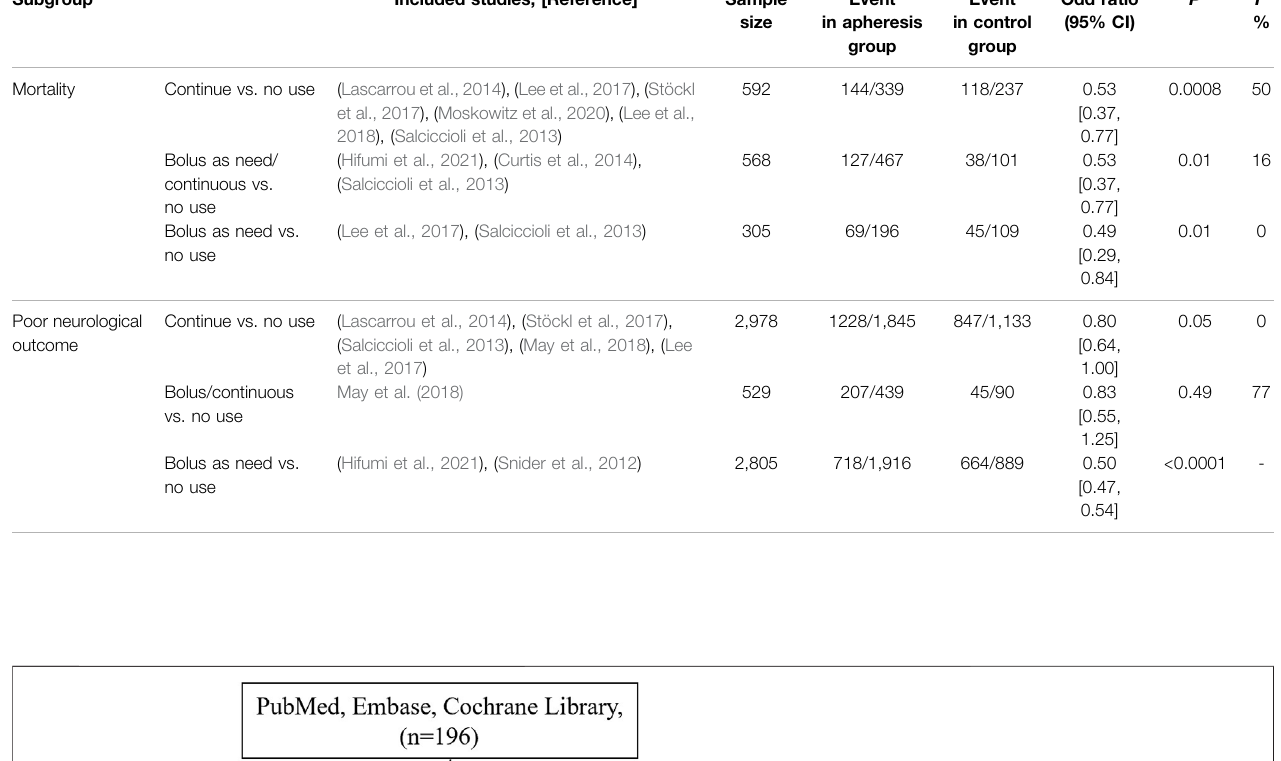
TABLE 2 | Subgroup analysis of the mortality and Poor neurological outcomes based on NMB regimens. Subgroup